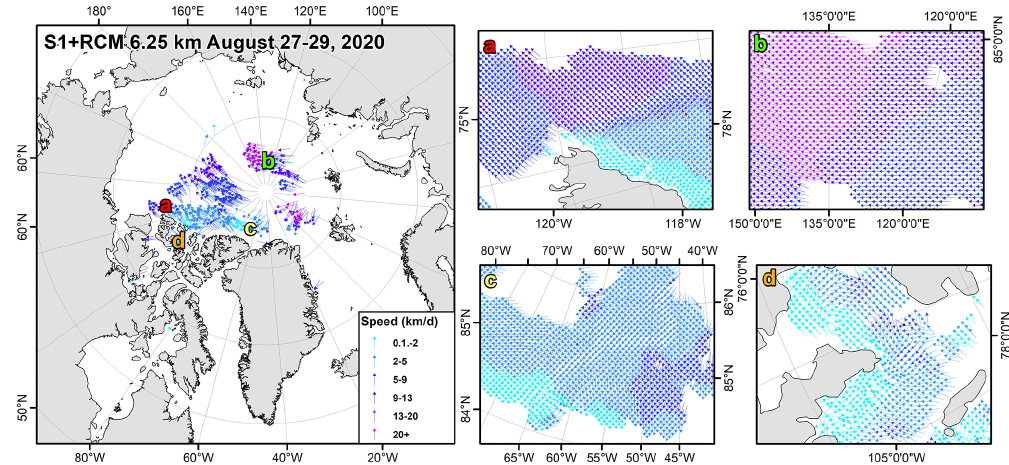
Figure 11. The spatial distribution of 6.25km 3d S1 + RCM sea ice motion on 27–29 August 2020. The letters correspond to zoomed-in regions on the map. Note that the white areas in the figure indicate either zero ice motion for the landfast ice or no ice motion information extracted (because of no SAR data, no ice, or no stable ice